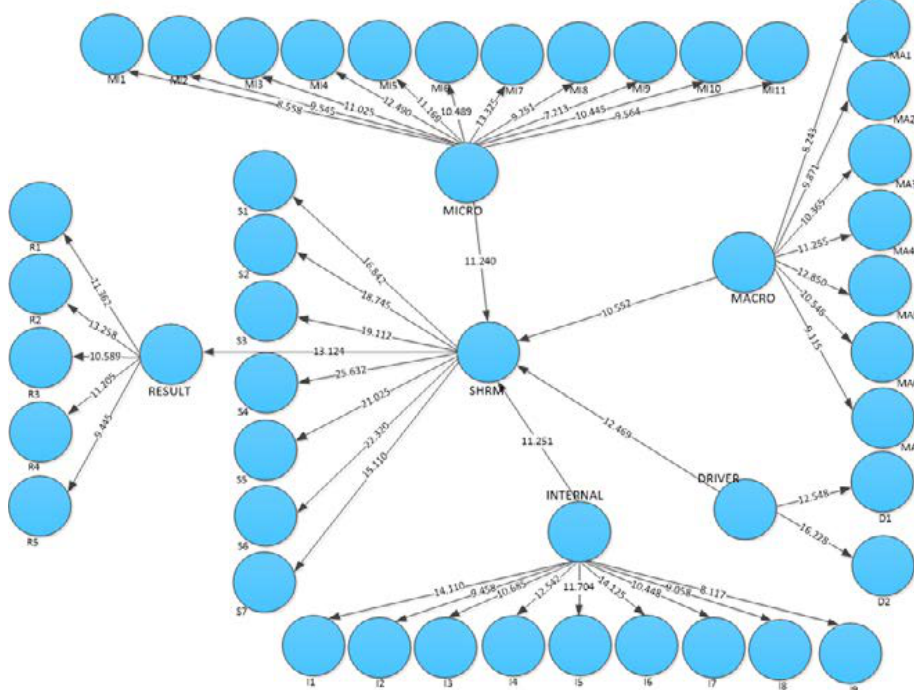
Fig. 2: Structural model of the research in the case of significant coefficients